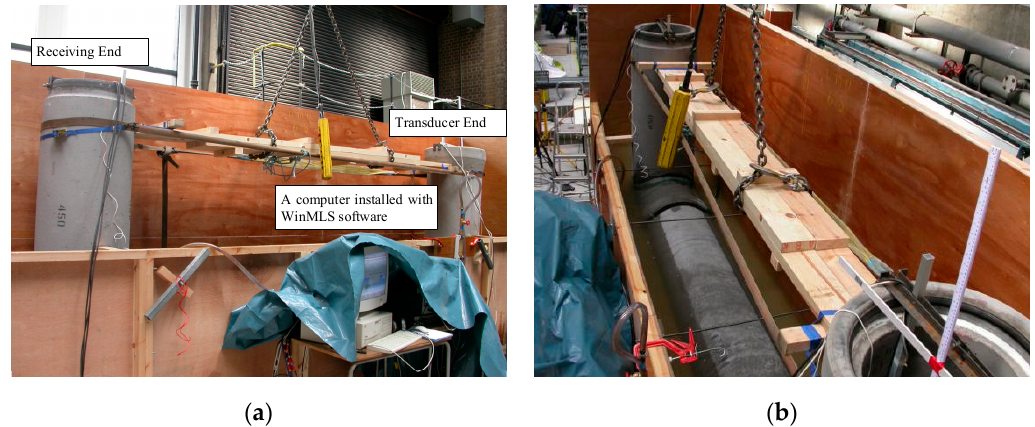
Figure 2. Photograph of the Siphon Experimental setup in the Hydraulics Laboratory at the University of Bradford.